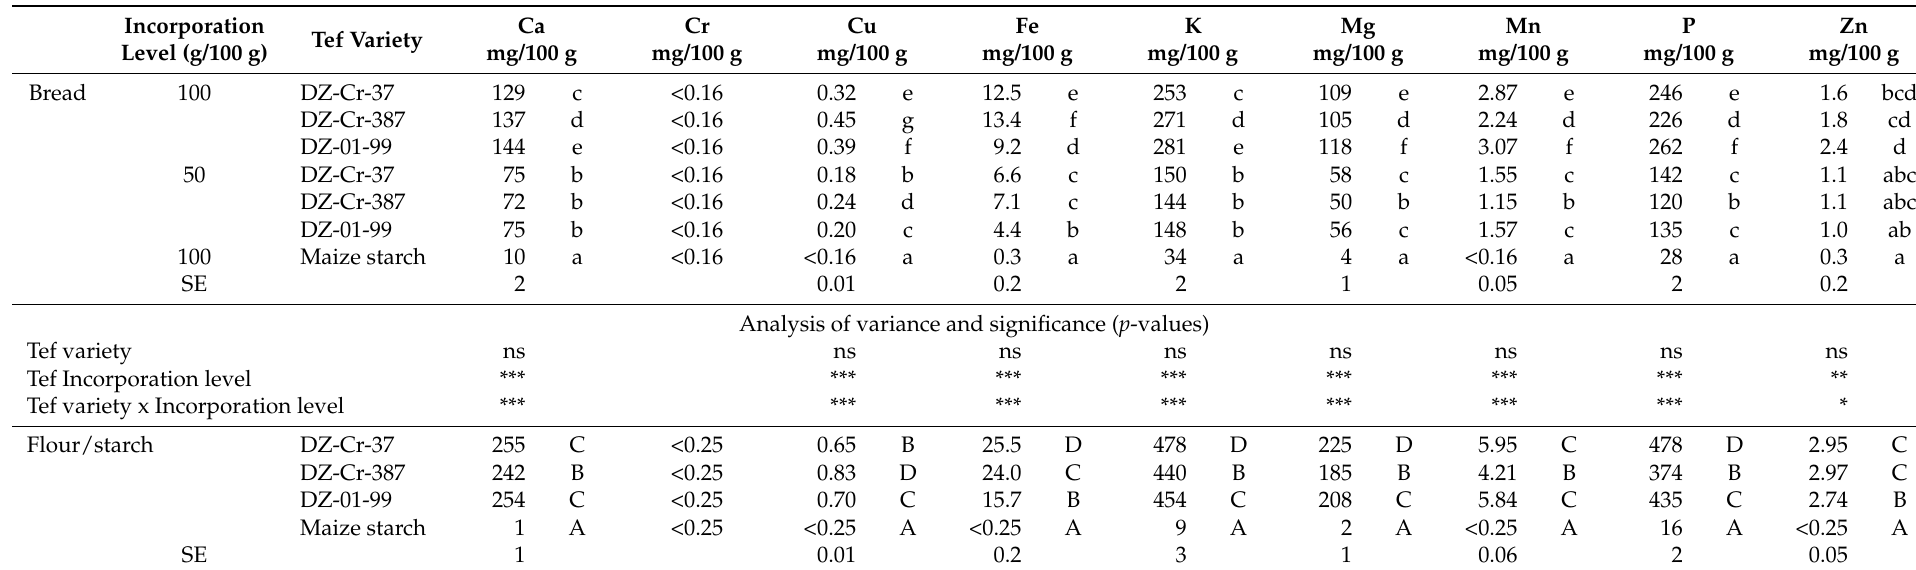
Table 3. Microelement content of tef-enriched GF breads and tef flours and maize